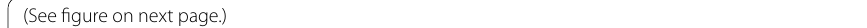
(See figure on next page.) Fig. 4 Downregulating SLC3A2 promotes HA-VSMC cell apoptosis. HCMV-miR-US33-5p was transfected into HA-VSMCs. A RNA sequencing data showing differential expression of SLC3A2 between HCMV-miR-US33-5p and control groups. B , C SLC3A2 expression in HA-VSMCs. D , E SLC3A2 expression in HA-VSMCs after silencing SLC3A2. F CCK-8 assay showed that transfection of siRNA targeting SLC3A2 inhibited HA-VSMC proliferation. G – I Flow cytometry assay ( G ), caspase-3 activity assay ( H ), and Western blot analysis of cleaved caspase-3 ( I ) showed that transfection of siRNA targeting SLC3A2 promoted HA-VSMC apoptosis. J – M Western blot analysis of the effect of SLC3A2 siRNA on p-FAK ( J ), p-Akt ( K ), pY20CAS ( L ), and GTP-Rac ( M ) in HA-VSMCs. Western blot was performed three times; representative images are presented. Numbers above lanes indicate the relative protein level, normalized relative to control samples. * P < 0.05, *** P < 0.001, **** P < 0.0001 ( n ANOVA